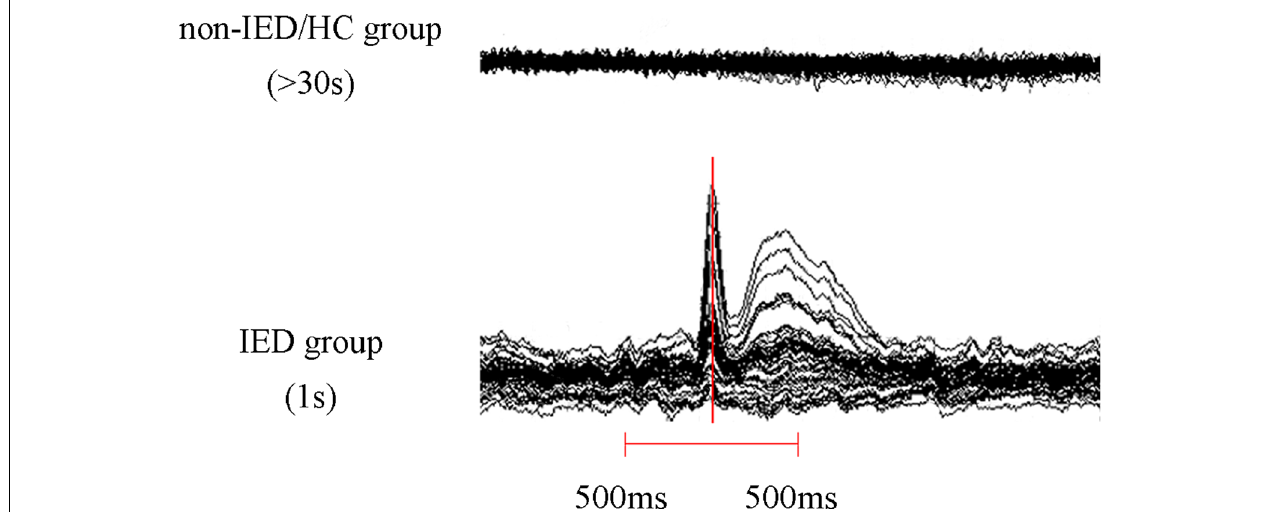
FIGURE 1 | Schematic of magnetoencephalography (MEG) data analysis. At least 30 s of MEG data was recorded in the non-interictal epileptiform discharges (IED) group and the healthy controls (HC) group and a 1 s segment (500 ms before and 500 ms after the maximum negative peak of the spike) MEG data was selected in the IED